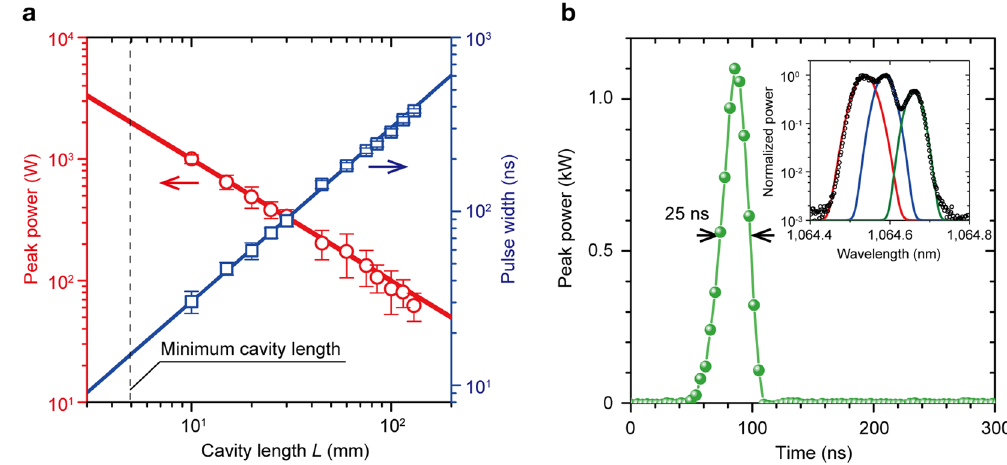
Figure 2. Output pulse characteristics. ( a ) Peak power and pulse width for varying L . Pumping energy: 6.4 mJ/pulse, corresponding pumping duration: 200 μ s. The solid lines indicate the calculated values, which agree well with the measured values. The thin dashed line indicates the minimum L achievable using the Nd:YAG and RIG film. ( b ) Output pulse shape with L = 10 mm. The peak power and pulse duration were 1.1 kW and 25 ns, respectively. Inset: output wavelength spectrum. Black circles show the measured data. Three peaks were observed at the wavelength of 1,064.54 (red line), 1,064.59 (blue line), and 1,064.66 nm (green line). The spectrum widths at each wavelength were 47, 39, and 35 pm,